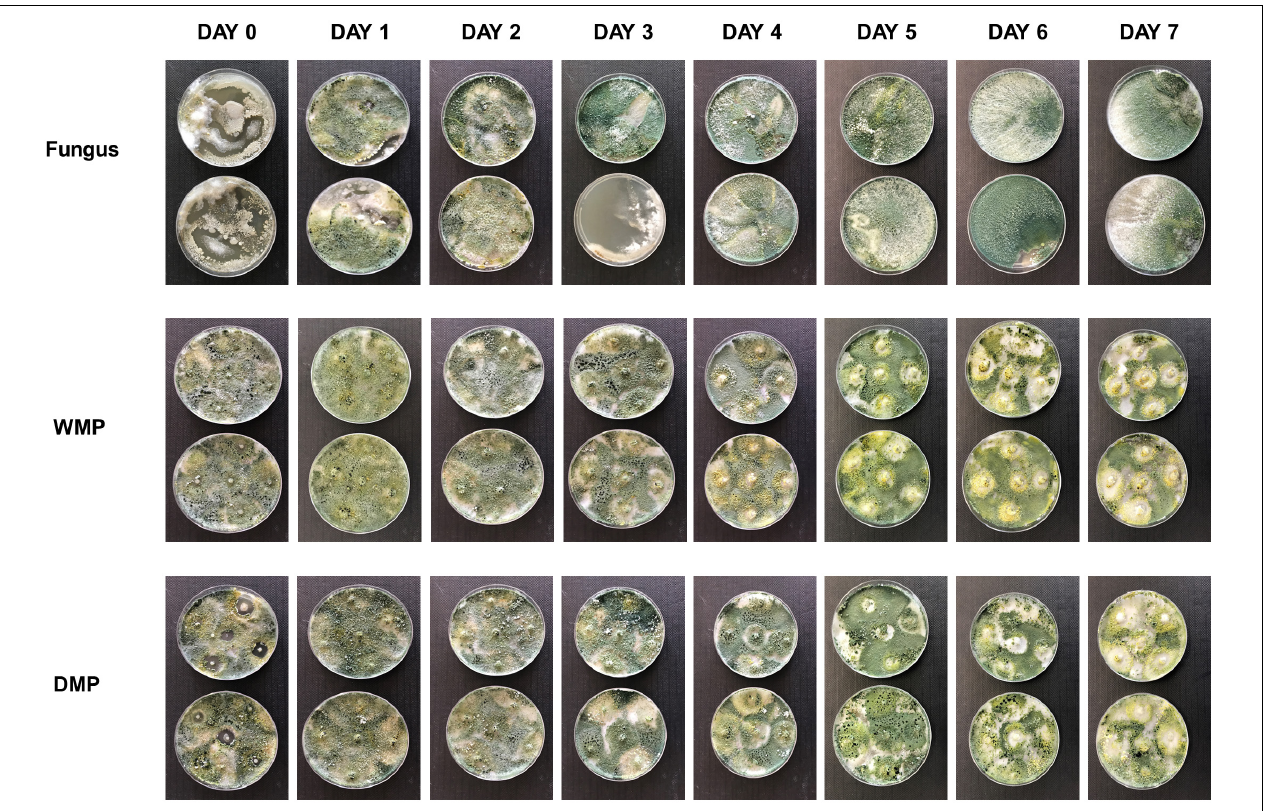
FIGURE 4 | Photostability assays after 7 days exposure to ultraviolet radiation, for the free fungus and the wet (WMP) and dry (DMP) microparticles containing encapsulated T. harzianum . The results showed that encapsulation of the fungus provided protection against ultraviolet